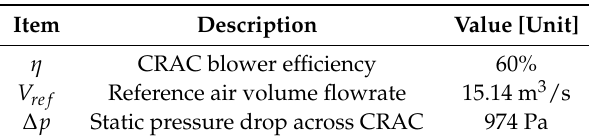
Table 1. Reference working condition of CRAC